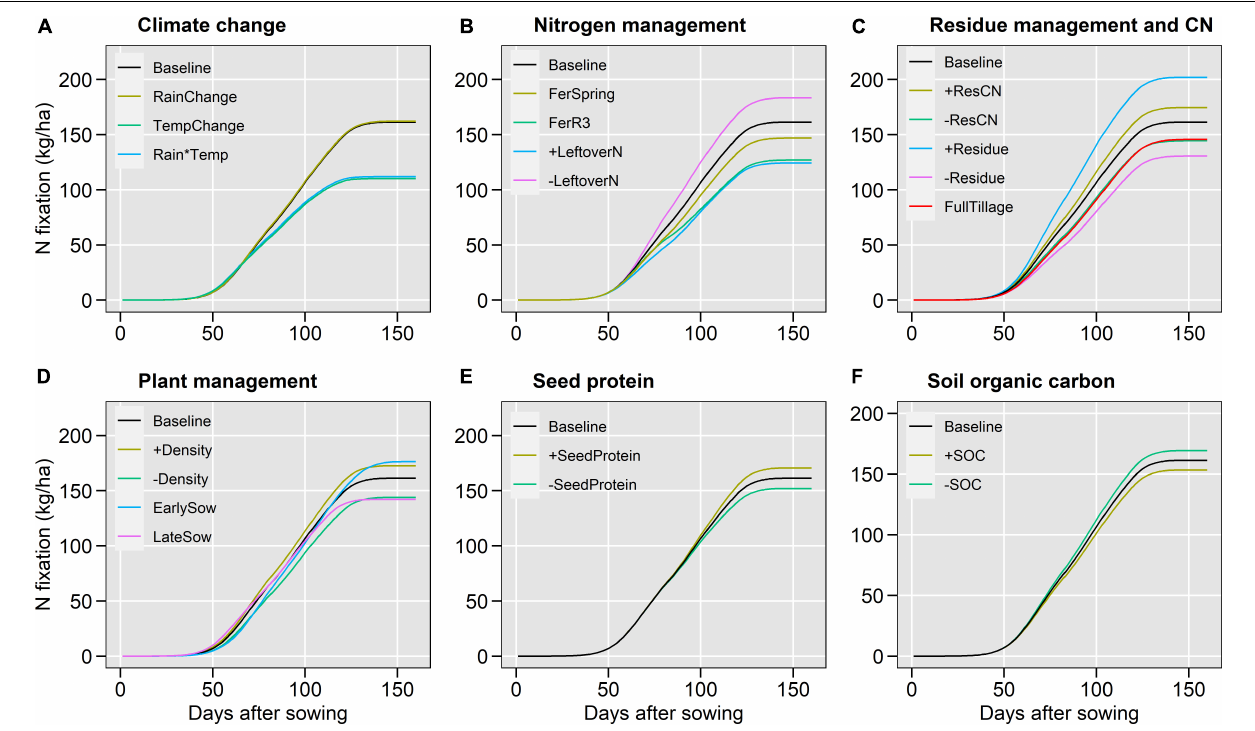
FIGURE 5 | GxExM effects on cumulative aboveground N fixation during the soybean growing season for different scenarios including climate change (A) , nitrogen management (B) , residue management and quality (C) , plant management (D) , seed protein (E) and soil organic carbon (F) . Values were averaged over 10 locations and 25-years per